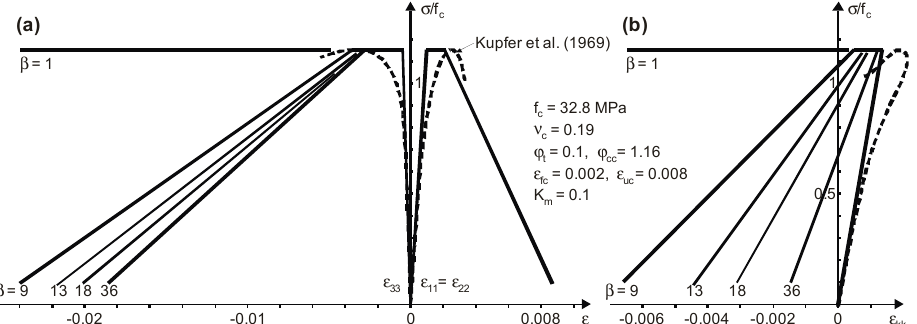
Figure 6. Comparison of the proposed model with experimental results for biaxial compression: ( a ) graph of stress vs. longitudinal and lateral strains; ( b ) graph of stress vs. volumetric strains.